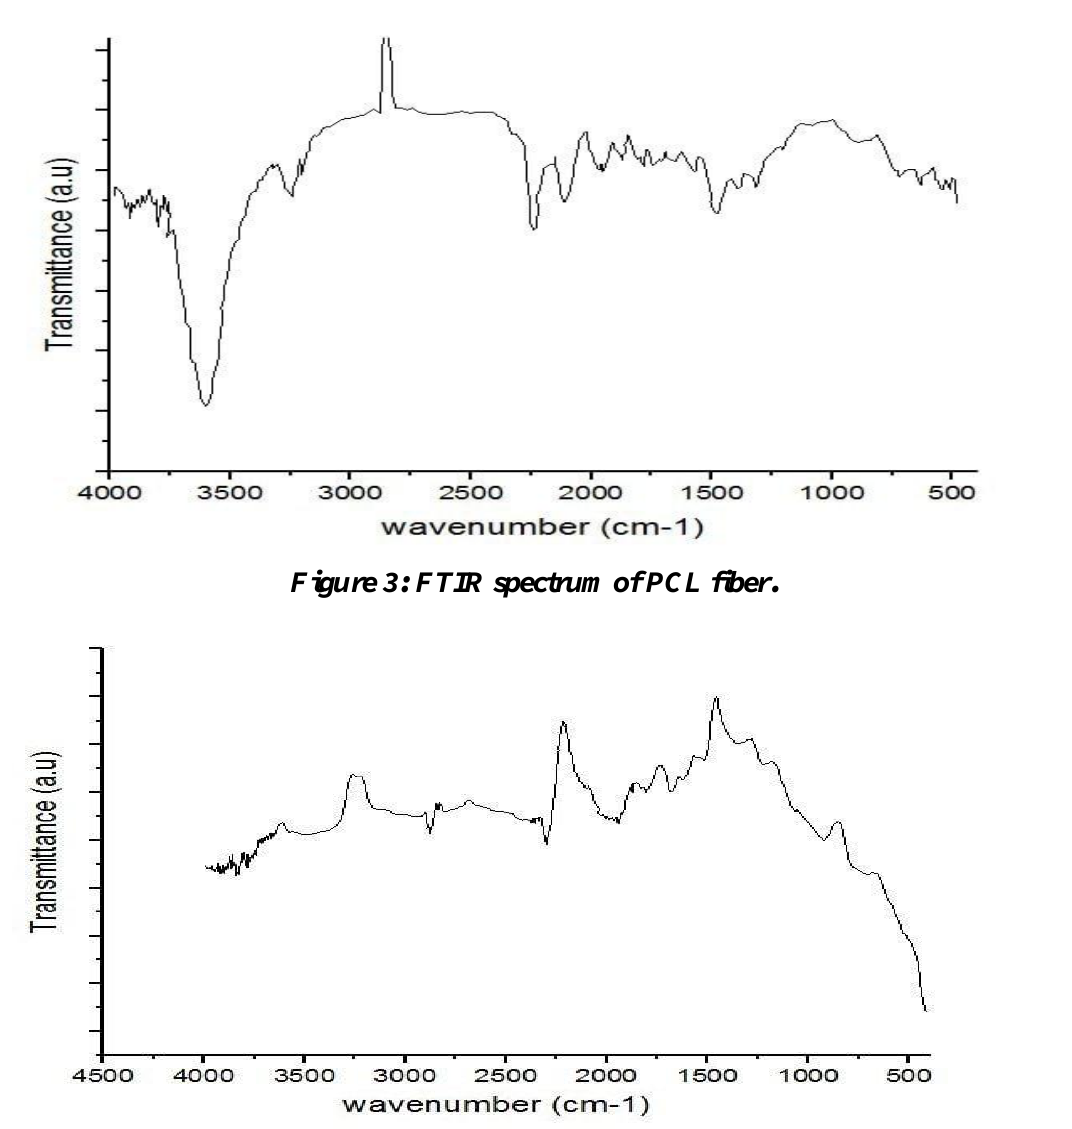
Figure 4: FTIR spectrum of PCL/HA